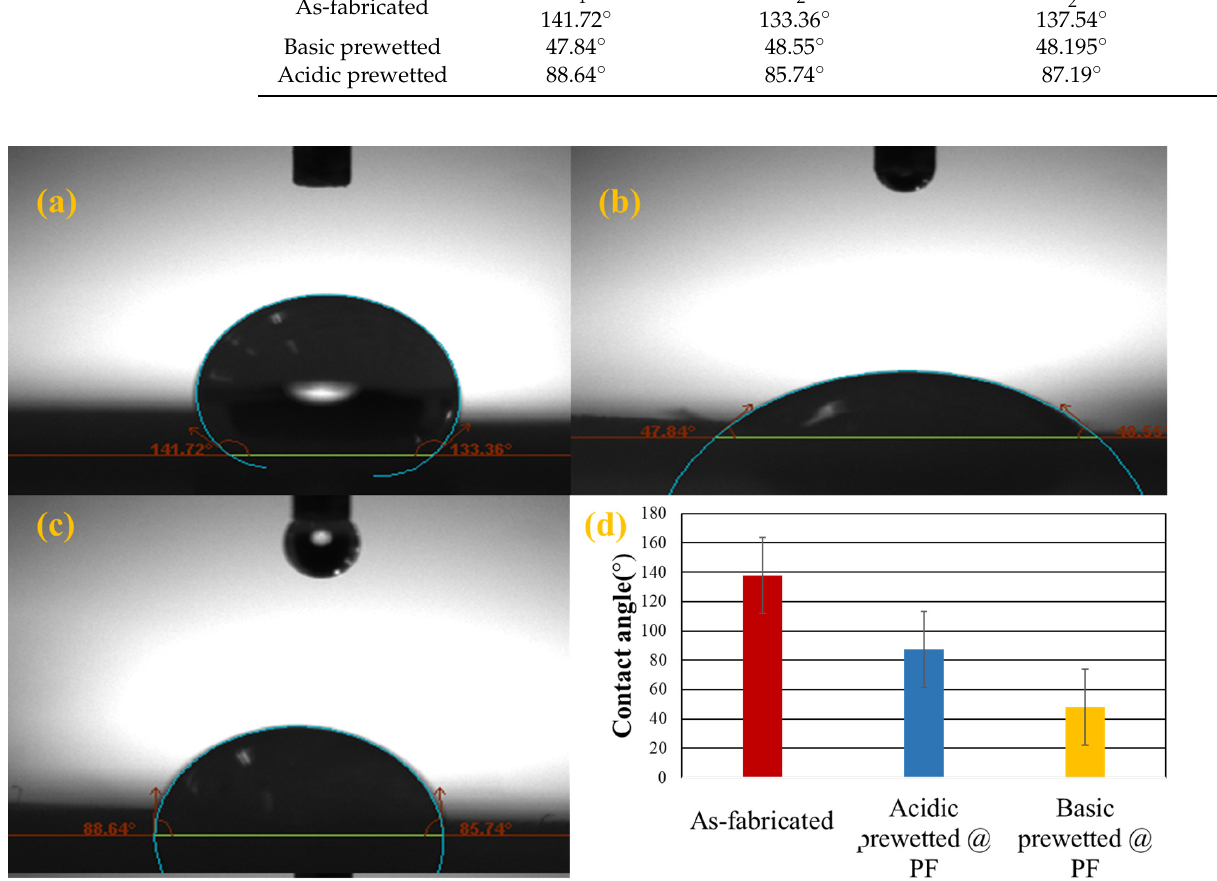
Figure 6. The average water contact angle of the ( a ) as-fabricated nanocalcite @ PF, ( b ) basic